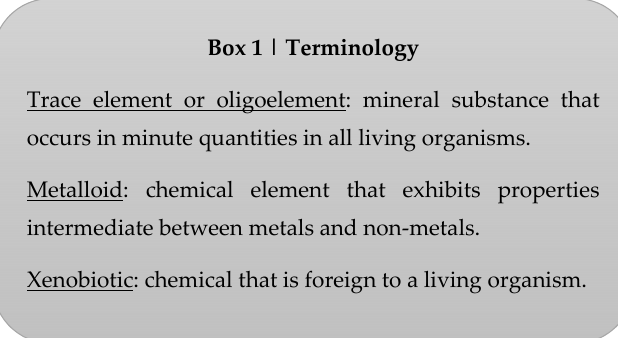
Figure 1. Specific terminology frequently used in the text.